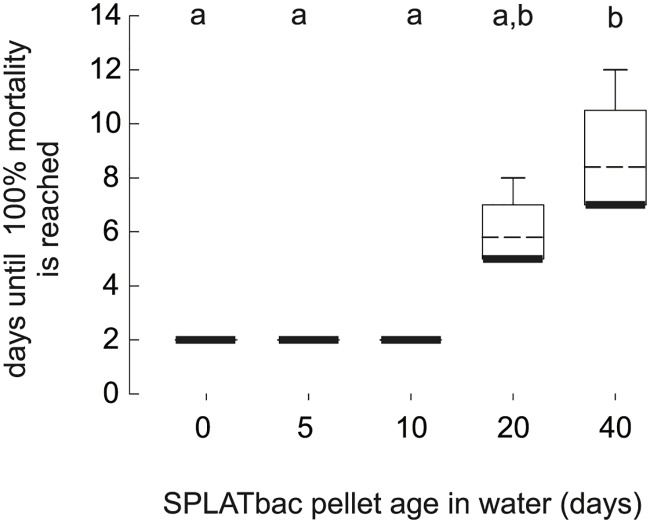
Aging of SPLATbac pellets slows mortality of newly hatched Cx. quinquefasciatus larvae.Box plots are shown with medians (bold lines) and arithmetic means (dashed lines). Different letters indicate statistically significant differences (Dunn’s pairwise multiple comparisons, p < 0.05) between SPLATbac post-application periods.